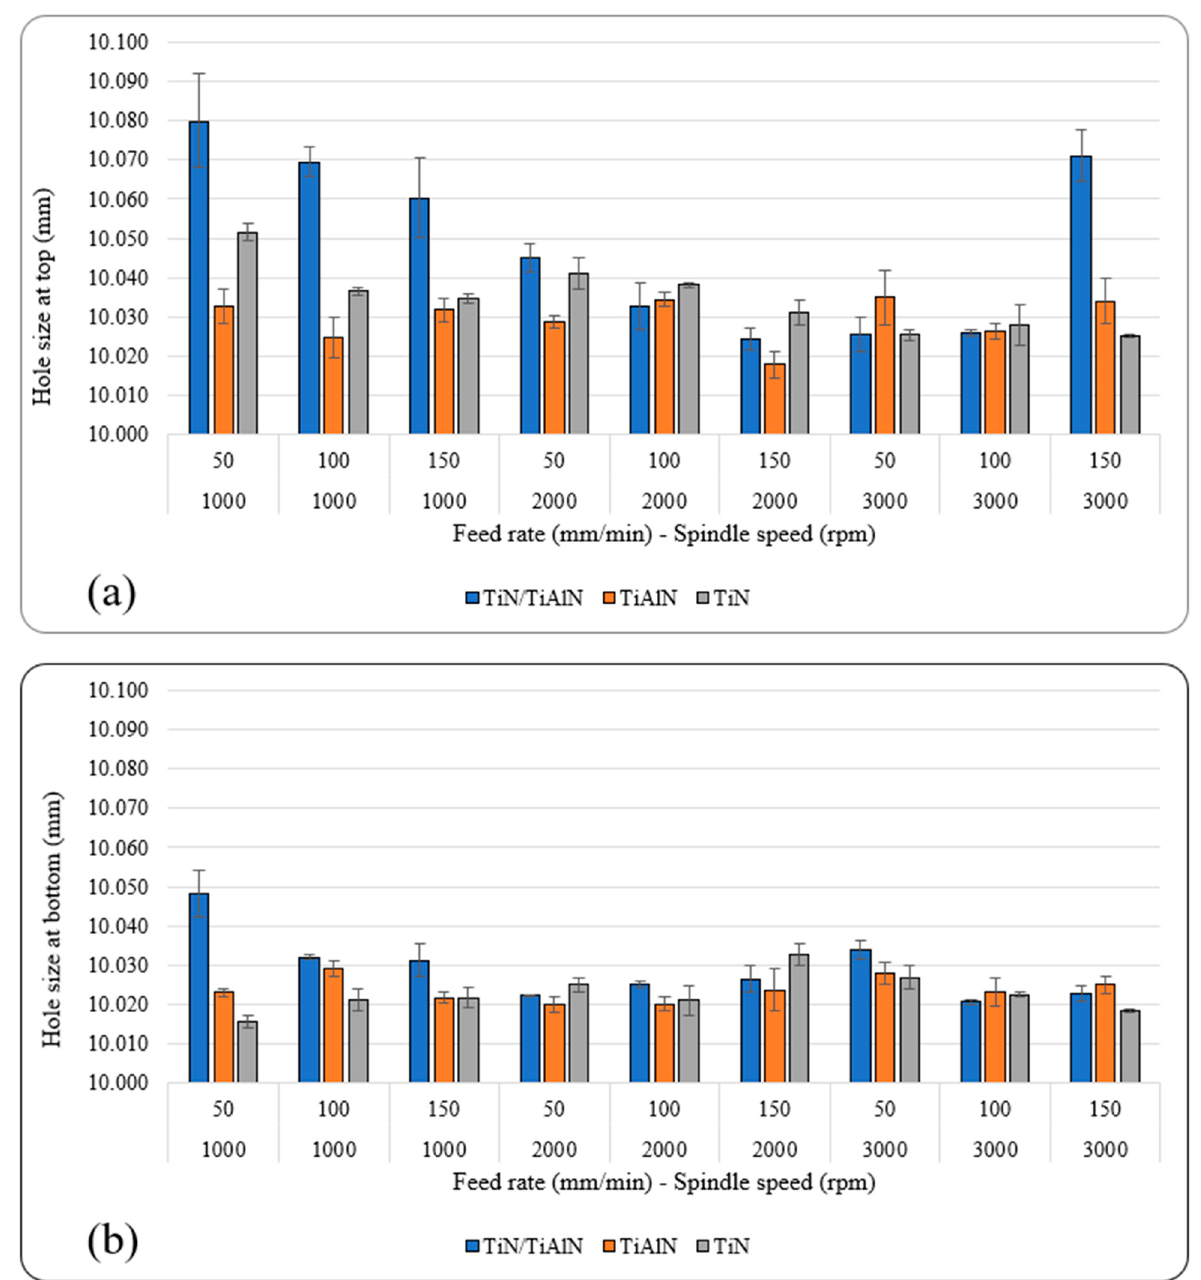
Figure 7. Average hole size: ( a ) at the top of the hole; ( b ) at the bottom of the hole. The hole size at the bottom was always smaller than that at the top under all cutting parameters and tool coatings used. This is possibly due to the drill “wander” on contact with the workpiece, where it is point-supported, then at further depth, where it is point- and side-supported [39,54]. Vibratory displacement occurred during the initial contact between the chisel edge and the workpiece (i.e., hole entry), which triggered dynamic instability, causing higher hole-size deviations at the top than at the bottom [39,45]. Hole size in this study ranged between 15.47 μ m and 79.9 μ m, as shown in Table 6.